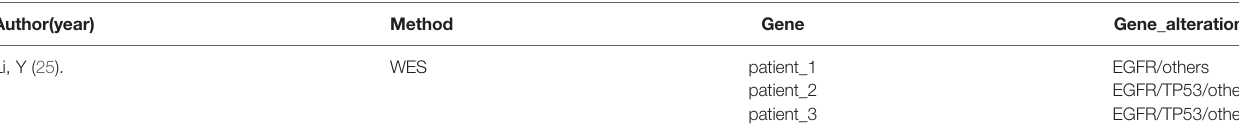
TABLE 3B | Three cases con fi rmed by Li, Y (25). which applied WES to analyze gene alterations in their research. Author(year) Li, Y